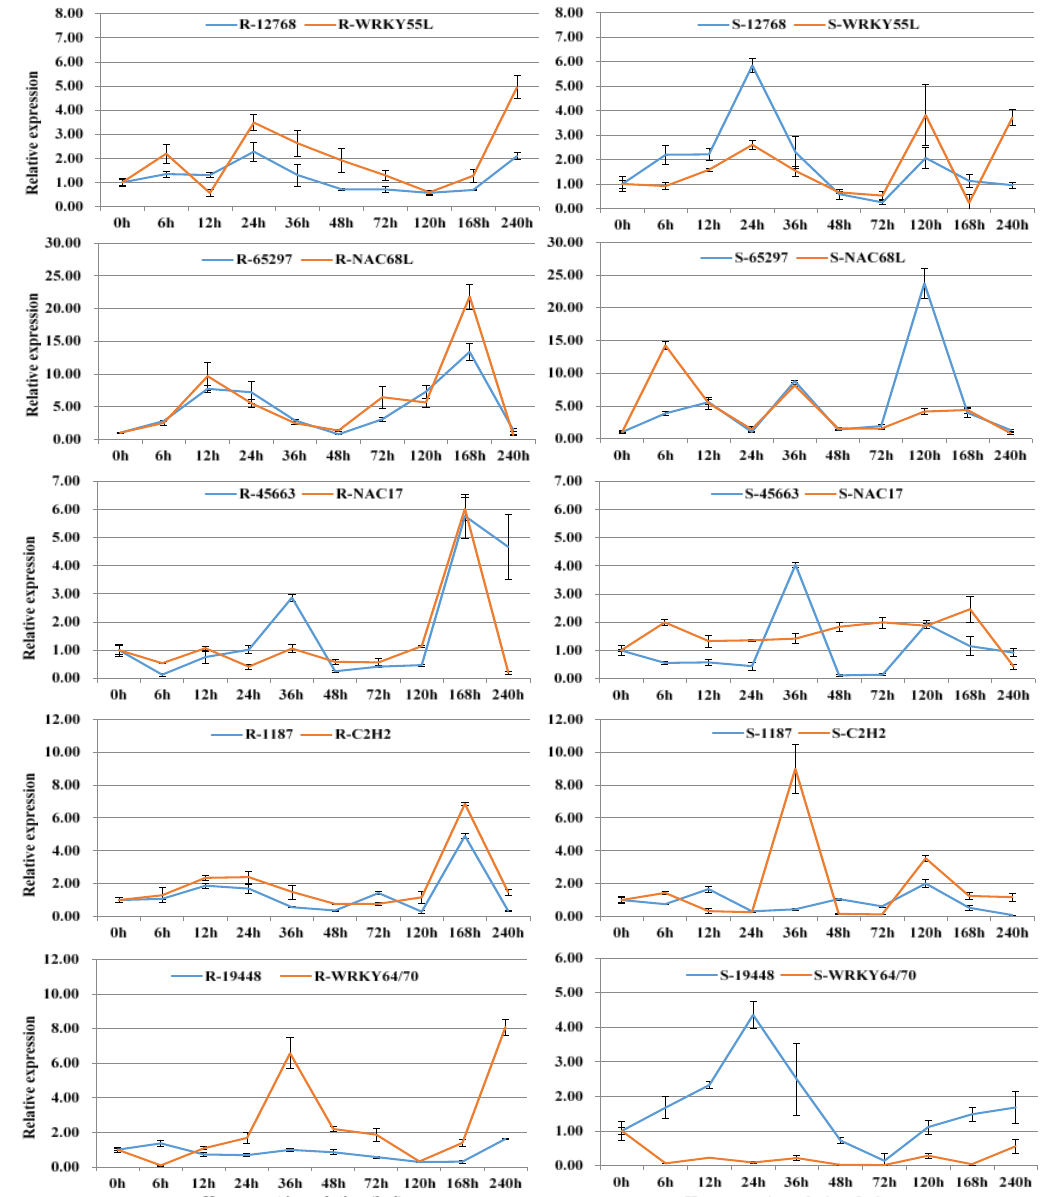
Figure 1. Expression patterns of long noncoding transcripts (lncRNAs) and their nearby transcription factors in the near isogenic lines N9134R and N9134S induced by powdery mildew infection at 0, 6, 12, 24, 36, 48, 72, 120, 168, 168, and 240 hpi. Gene expression levels were assessed by Q-PCR and data were normalized to the actin expression level in wheat. The mean expression value was calculated using three independent replicates. The vertical bars represent the standard deviation in three repeats. The letters ‘R’ and ‘S’ represent resistance and susceptible lines, respectively. Blue and orange lines represent the expression pattern of lncRNAs and TFs separately.